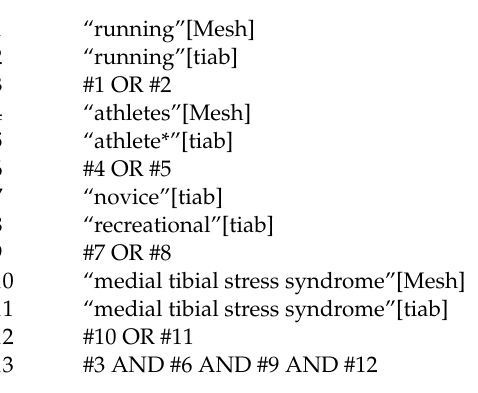
Table A1. Search Strategy for PubMed /